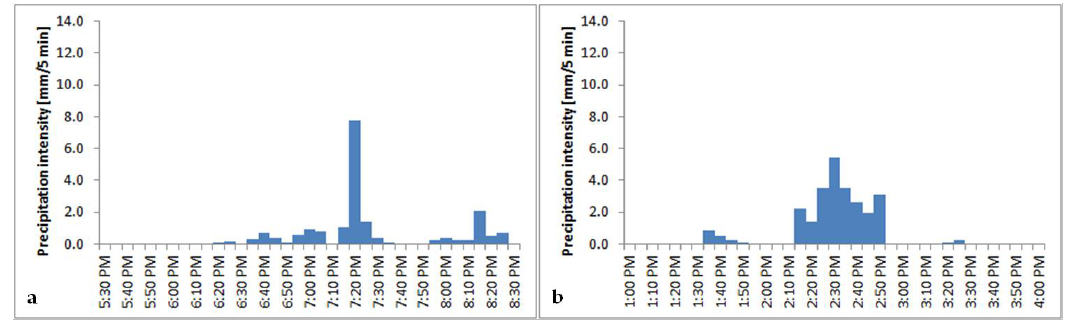
Figure 7. The storm event and its intensities for the RY-product on ( a ) 23 and ( b ) 31 May